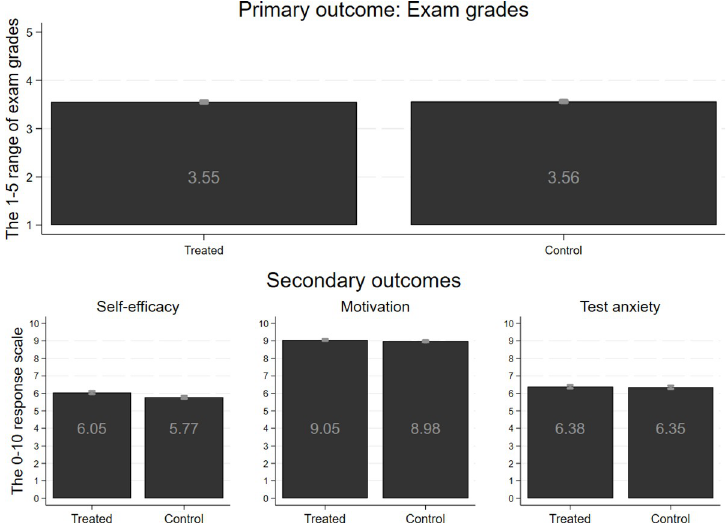
Fig 5. The unconditional raw mean of primary and secondary outcome variables in treated and control groups with 95% confidence intervals.